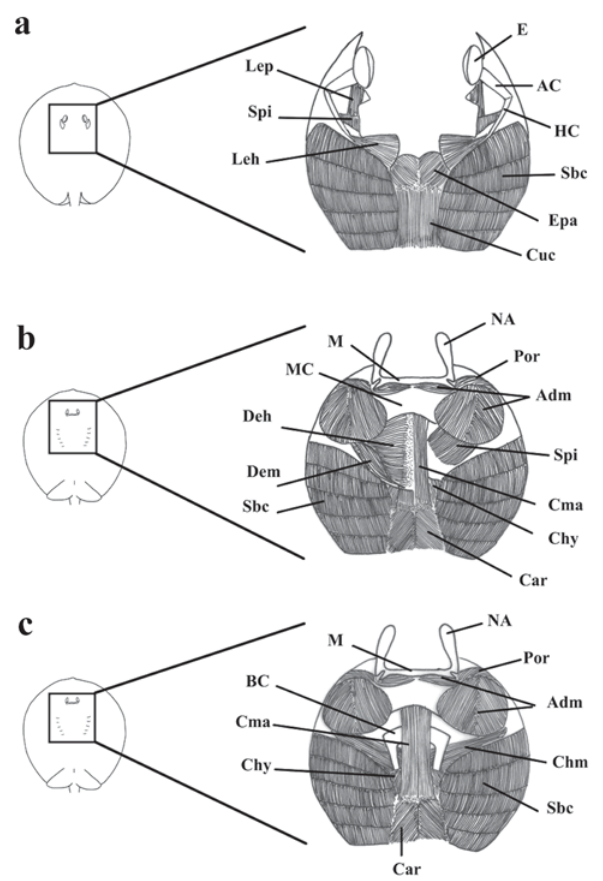
Table 1. Comparison of the relative wet biomass (%) between specimens of Potamotrygon motoro analyzed by Pantano- Neto (2001) and by the current